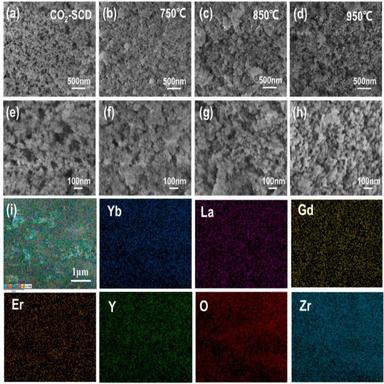
(a-h) SEM images of aerogel samples treated with different temperature: (a, e) CO2-SCD, (b, f) RZ-750, (c, g) RZ-850, (d, h) RZ-950, and the (i) EDS-mapping images of RZ-850.